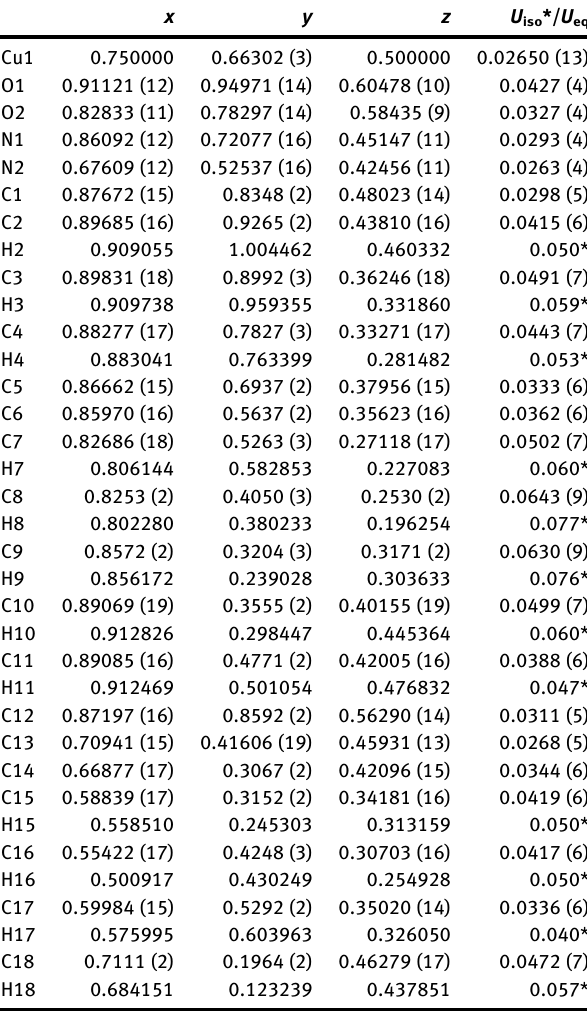
Table  : Fractional atomic coordinates and isotropic or equivalent isotropic displacement parameters (Å 